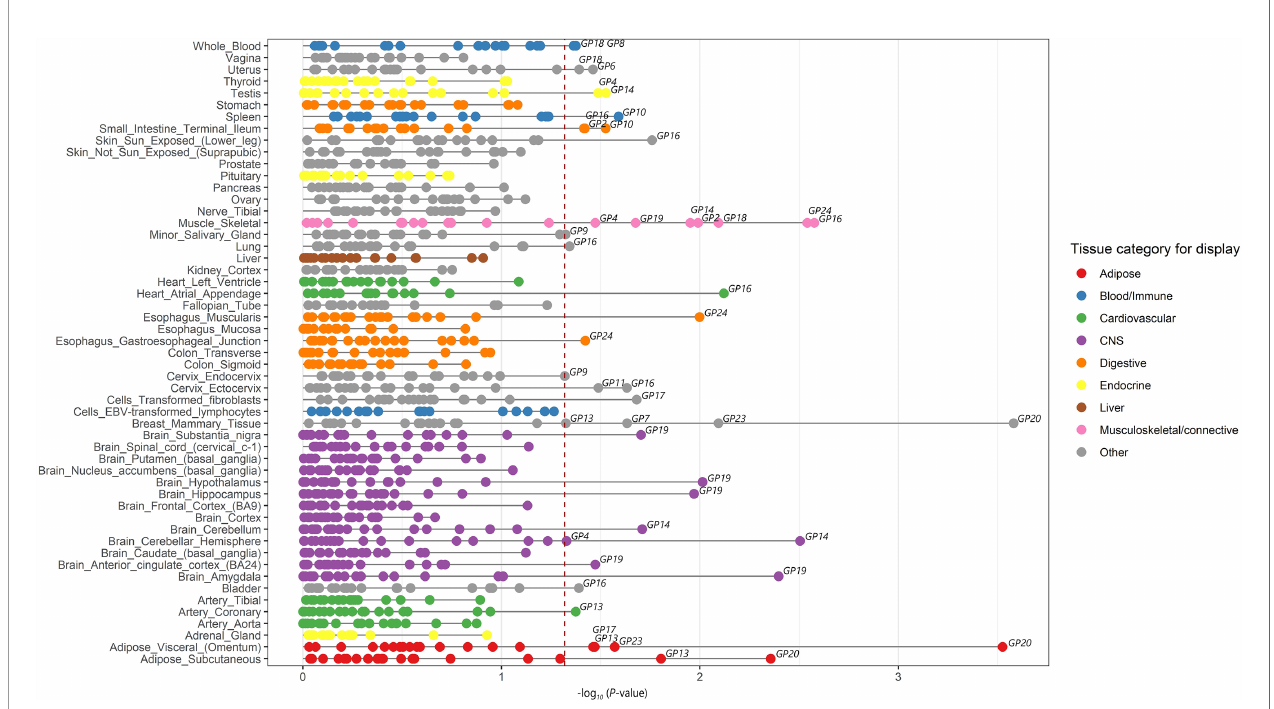
FIGURE 2 | Enrichment of tissues in IgG N-glycosylation. Signi fi cantly enriched tissues of IgG N-glycosylation were identi fi ed by linkage disequilibrium score regression in a speci fi cally expressed gene (LDSC-SEG) approach. A total of 53 types of tissue obtained from the Genotype-Tissue expression project (GTEx v7) are grouped into nine domains with different colors. Twenty IgG N-glycan peaks (GPs) with signi fi cant GWAS results are enriched in all 53 types of tissue. Twenty-seven tissues are highly enriched for IgG N-glycosylation GWAS signals among 53 types of tissues, with a FDR signi fi cant at 5% (red dotted